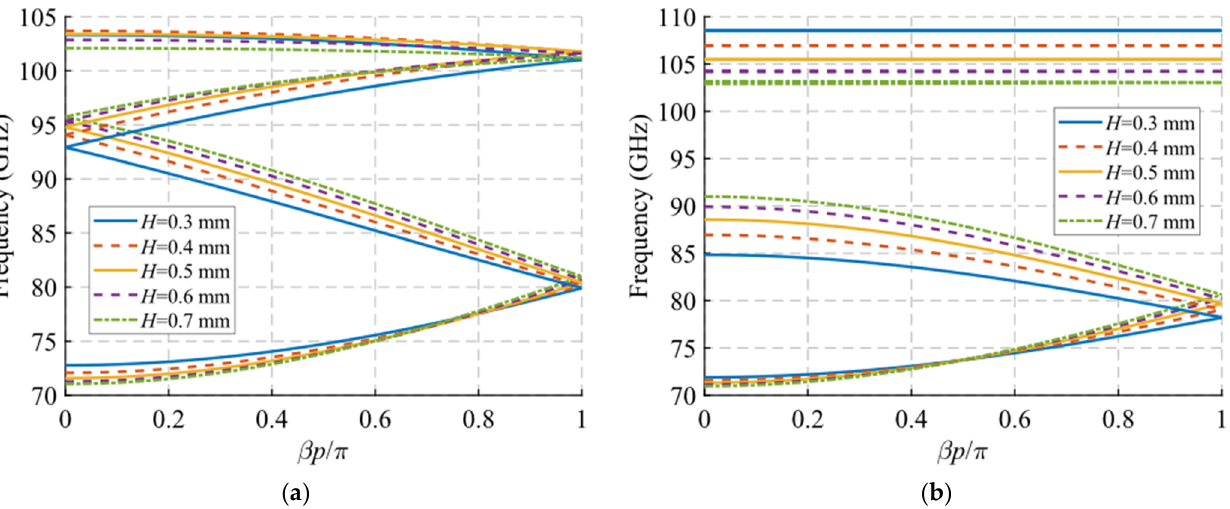
Figure 6. Dispersion diagram of the double-periodic unit cell for various values of H . ( a ) Glide- symmetric configuration ( d = 0.725 mm) and ( b ) maximum rupture of symmetry configuration ( d = 0